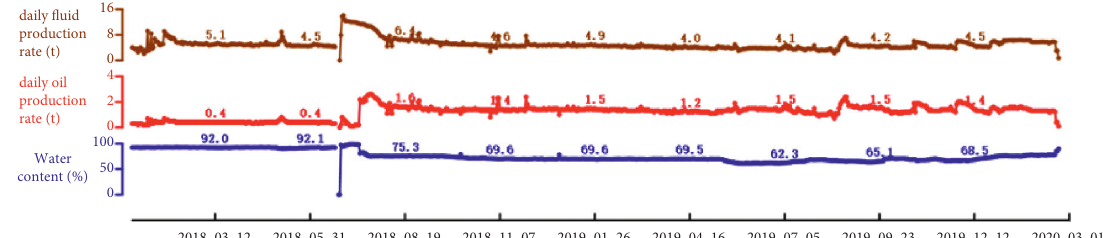
Figure 9: Oil production curve of well Luo 321-2.